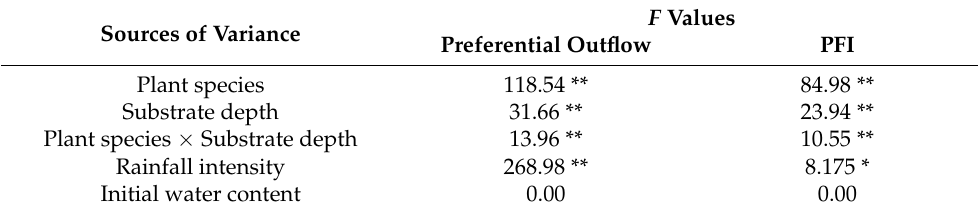
Table 7. Multi-factor ANOVA results for preferential outflow and PFI of PAS.